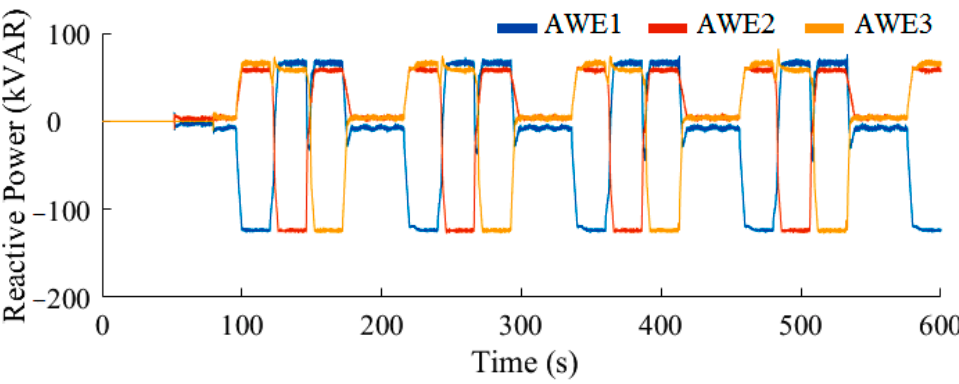
Figure 12. AWE farm reactive power exchange without RPC active.